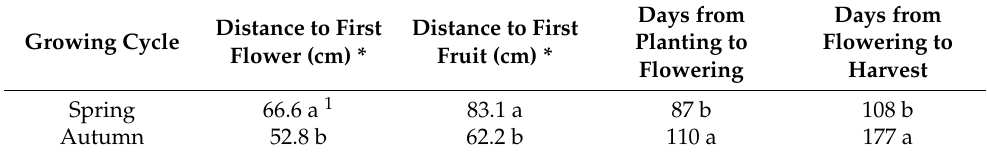
Table 1. Morphological features of ‘Intenzza’ papayas of spring versus autumn planting season.